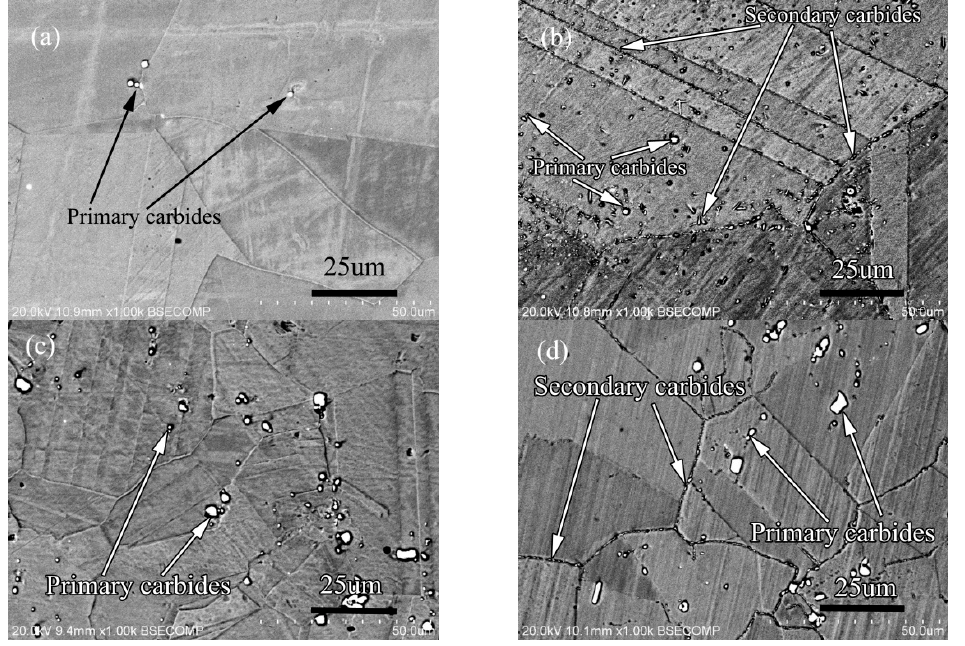
Figure 17. Microstructure of alloy: ( a ) 0.011C alloy solid solution state, ( b ) 0.01C alloy aging state, ( c ) 0.045C alloy solid solution state, ( d ) 0.045C alloy aging state.